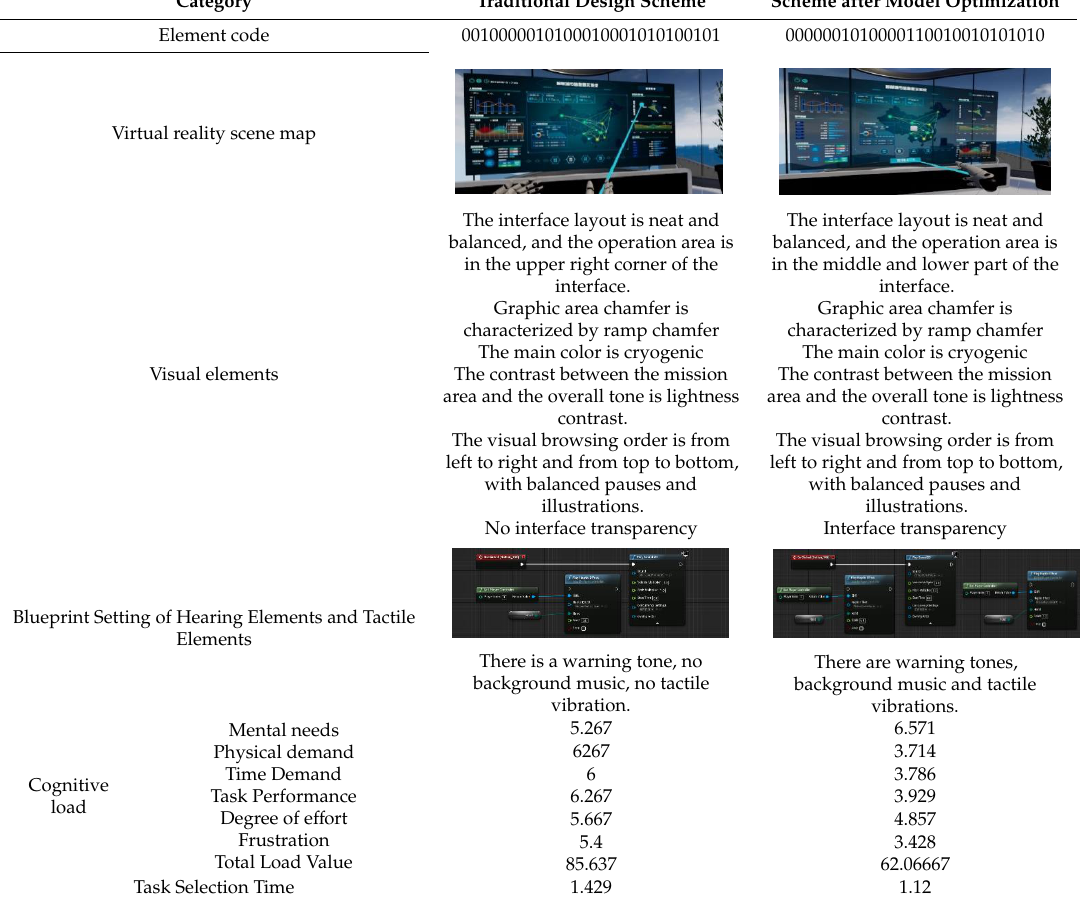
Table 15. Comparison table of optimization schemes.